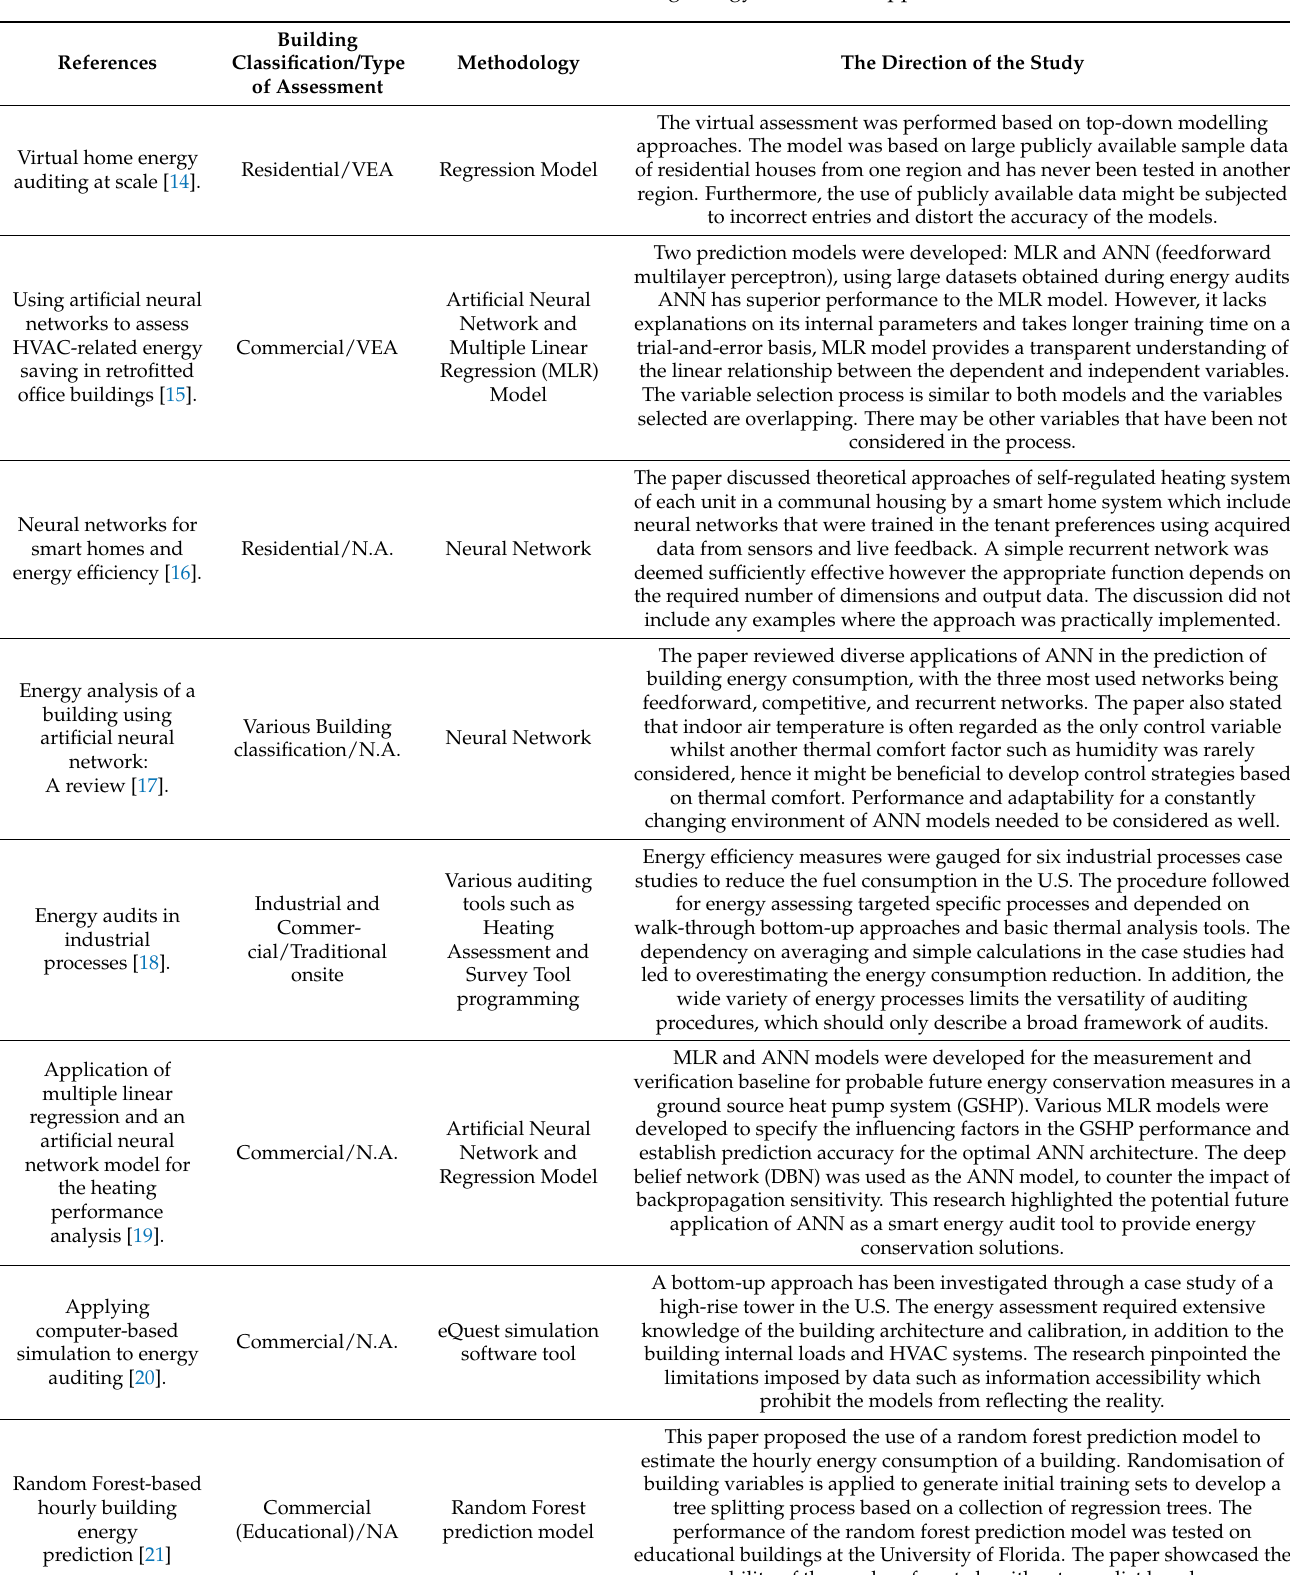
Table 1. Literature review of building energy assessment